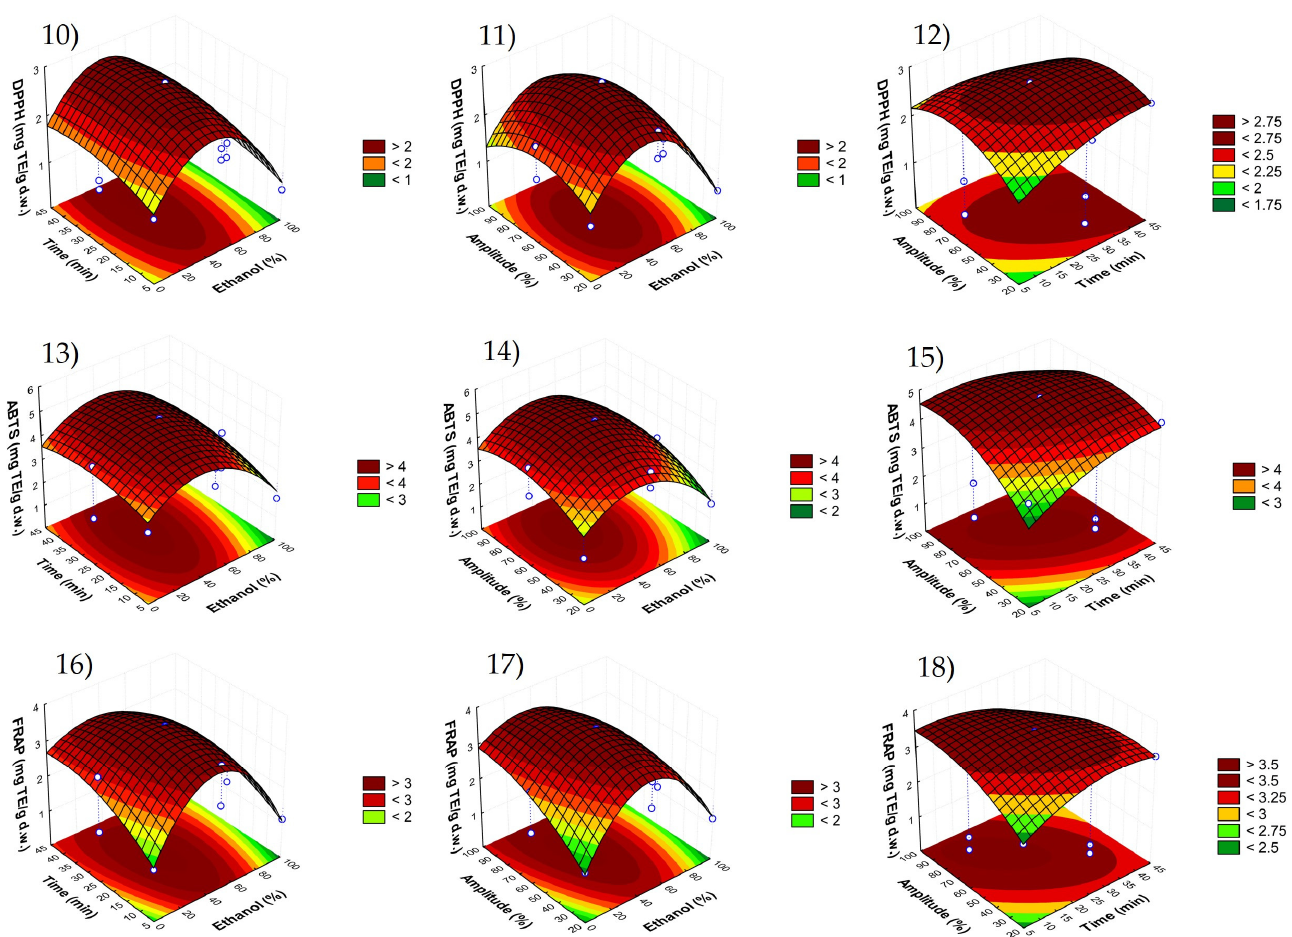
Figure 3. Response surface graphs (10–18) showing the combined effects of the process variables: ethanol (%), time (min) and amplitude (%) for the response variables 10–12: DPPH; 13–15: ABTS; 16–18: